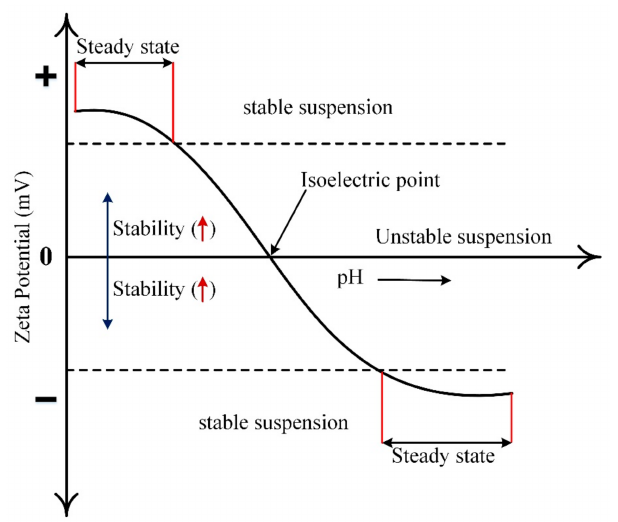
Figure 3. Schematic illustration of a zeta potential vs. pH curve showing the isoelectric point which determines the degree of a nanofluid’s